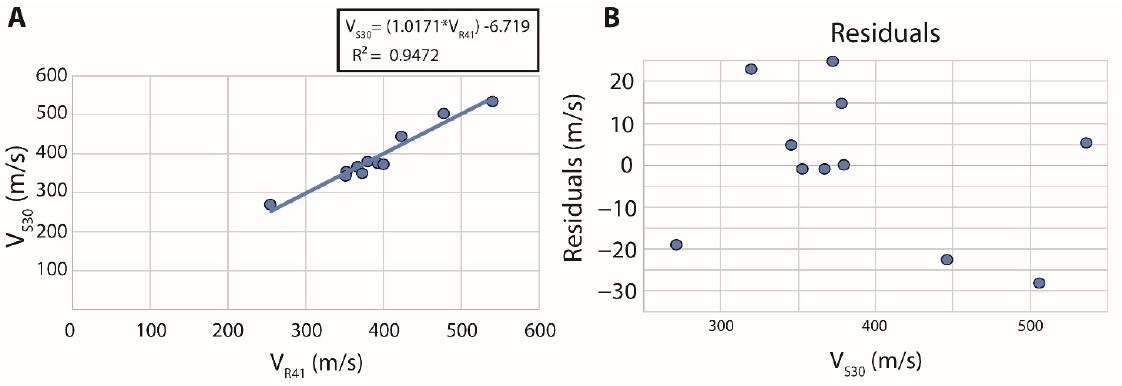
Figure 10. ( A ) Regression line (V S30 vs. V R41 ) and equation given. R 2 is the correlation coefficient. ( B ) The corresponding residual values.